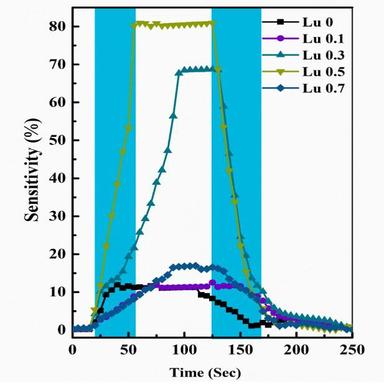
Sensitivity v/s time of ZnFe(2-x)LuxO4 where x = 0.01(Lu 0.01), 0.03 (Lu 0.03), 0.05(Lu 0.05), 0.07(Lu 0.07).